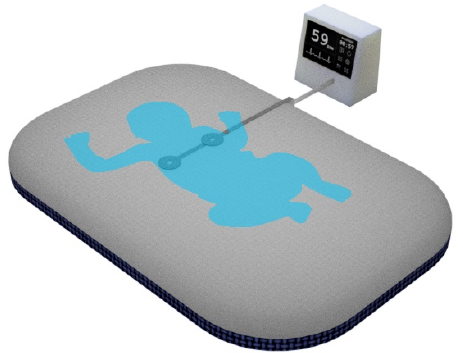
Figure 1. Delivery room mattress with embedded sensors.